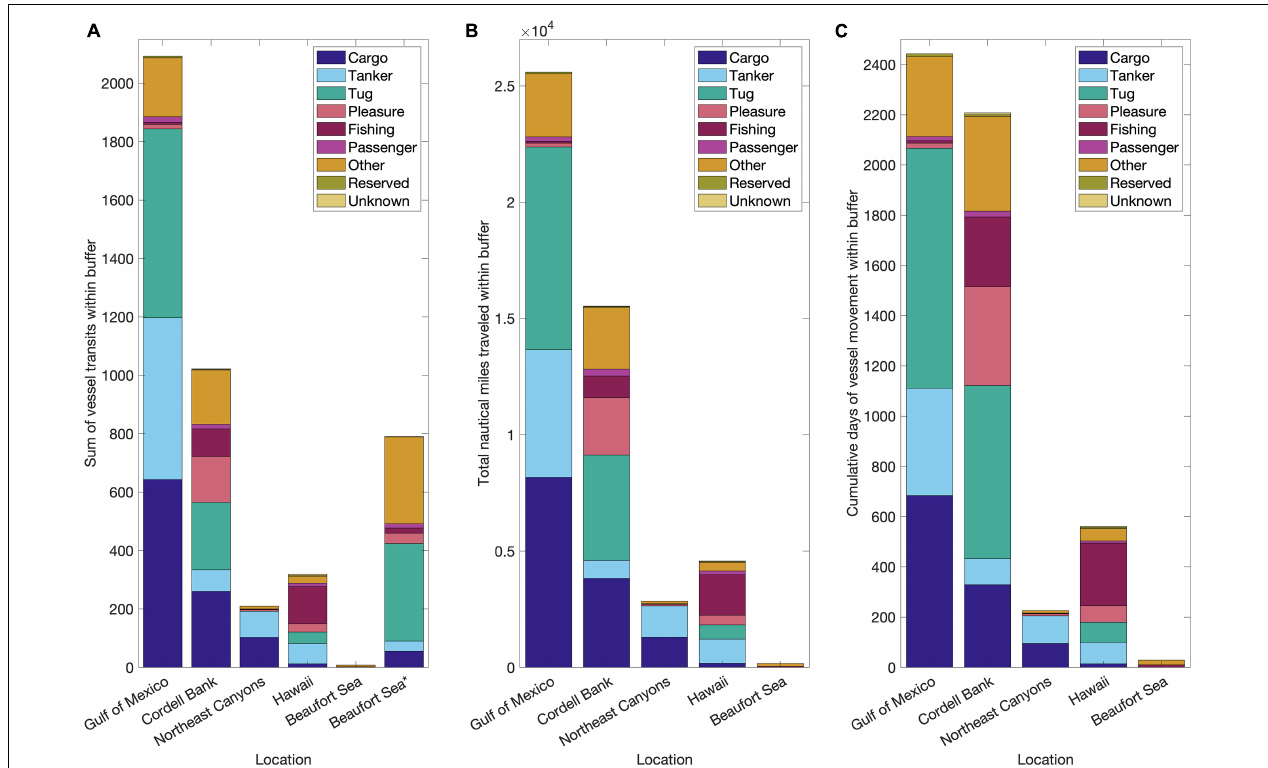
FIGURE 4 | Site-specific histograms of the monthly sum of unique vessel transits (A) , total distance traveled in nautical miles (B) , and cumulative time measured in days (C) within the buffer zone at each of the five deep-water autonomous underwater hydrophone moorings from January 2016 through August 2017. Each vessel type is color-coded: cargo-indigo, tanker-cyan, tug-teal, pleasure-rose, fishing-wine, passenger-purple, other-ochre, reserved-olive, unknown-sand. Note that the Beaufort Sea 150 km buffer zone is included in the plot of number of transits (A) denoted with asterisk, but not on the total distance (B) or sum of time plot (C) due to the unequal comparison of the amount time spent within 150 km compared to 20 km for the other